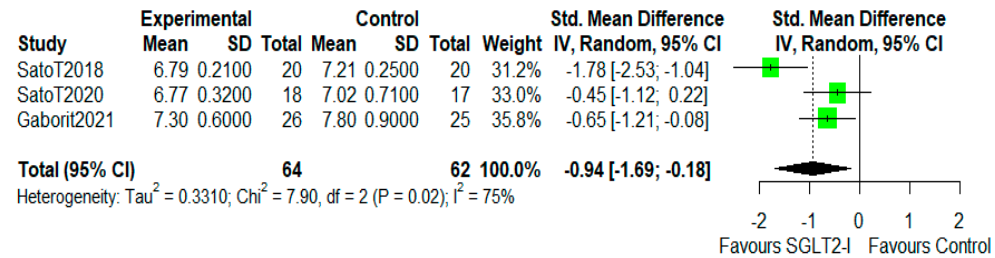
Figure 4. Effect of SGLT2 inhibitor therapy on HbA1c. Random − effects, standardized mean difference (SMD), 95% confidence intervals (CI), and I 2 statistics.